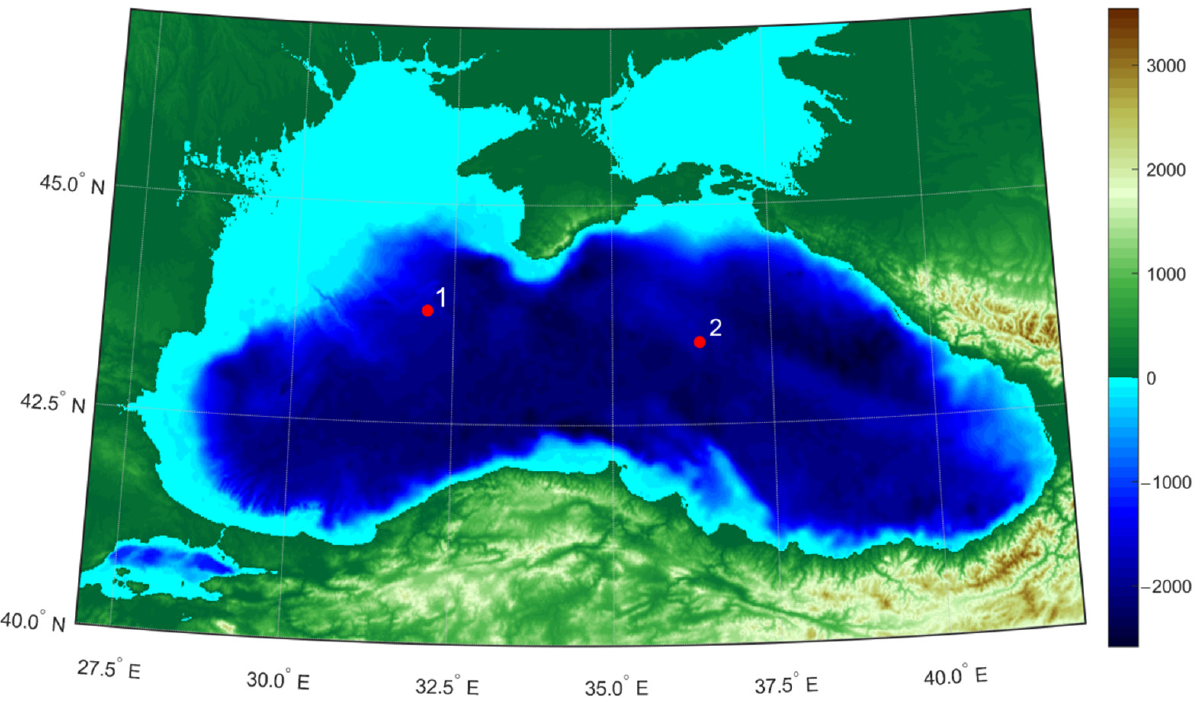
Figure 1. The anchored buoy stations (ABS) locations in 2016–2018. Bathymetry of the Black Sea according to ETOPO1 data doi:10.7289/V5C8276M. 1—is for ABS No. 1, 2—is for ABS No. 2.